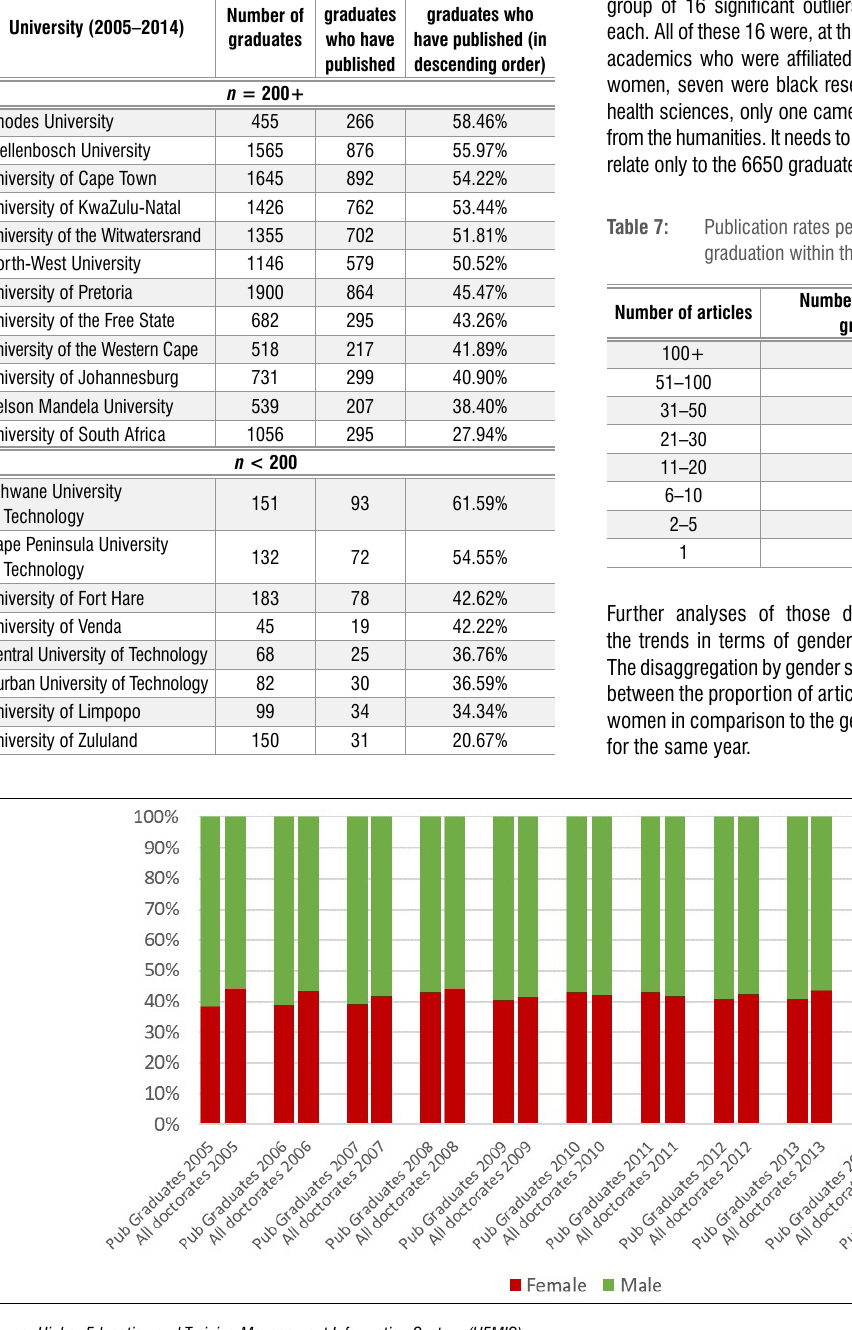
Figure 4: Published doctoral graduates disaggregated by gender and year compared to total doctoral graduates disaggregated by gender and